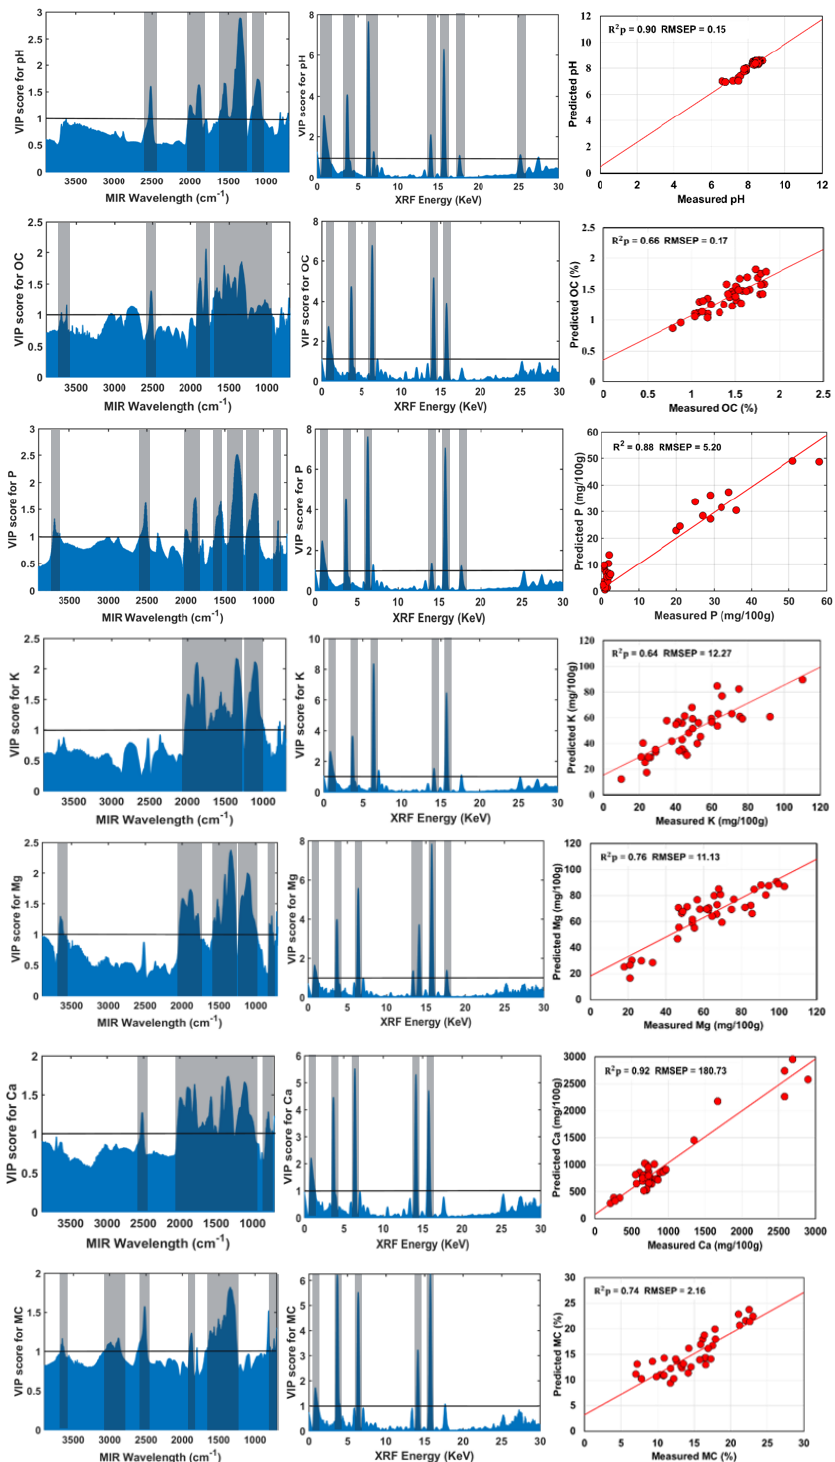
Figure 5. Variable impotence in projection (VIP) score plots for pH, organic carbon (OC), phosphorus (P), potassium (K), magnesium (Mg), calcium (Ca) and moisture content (MC) with corresponding scatter plots of measured against predicted values using the SF-VIP-SOPLS model developed based on selected variables. Units of root mean square error of prediction (RMSEP) are the same as units of respective soil properties. In VIP score plots the solid horizontal lines indicate the threshold values (value = 1) used for variable selection, and the vertical highlighted region is the significant range selected for prediction.